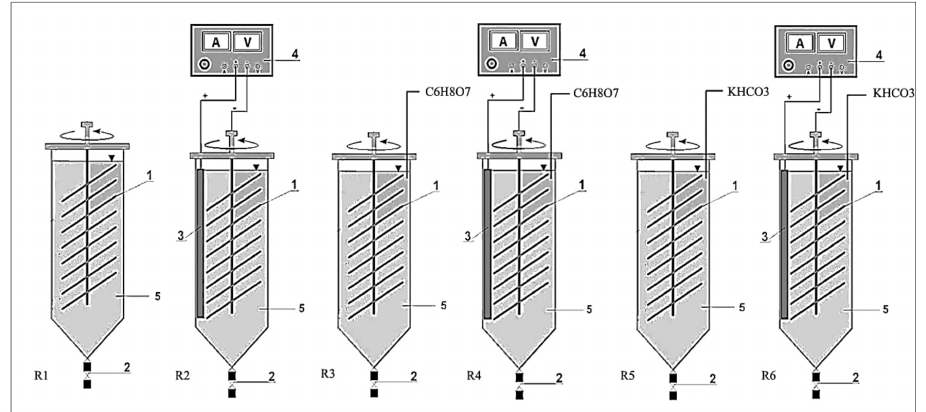
Figure 1. Scheme of the laboratory station: (1) cathode—discs with immobilized biofilm (stainless steel), (2) outflow, (3) anode (aluminum), (4) electric current source, (5) reactor: (reactor 1—R 0 , reactor 2—R H2 , reactor 3—R CA , reactor 4—R CA+H2 , reactor 5—R PB , reactor 6—R PB+H2